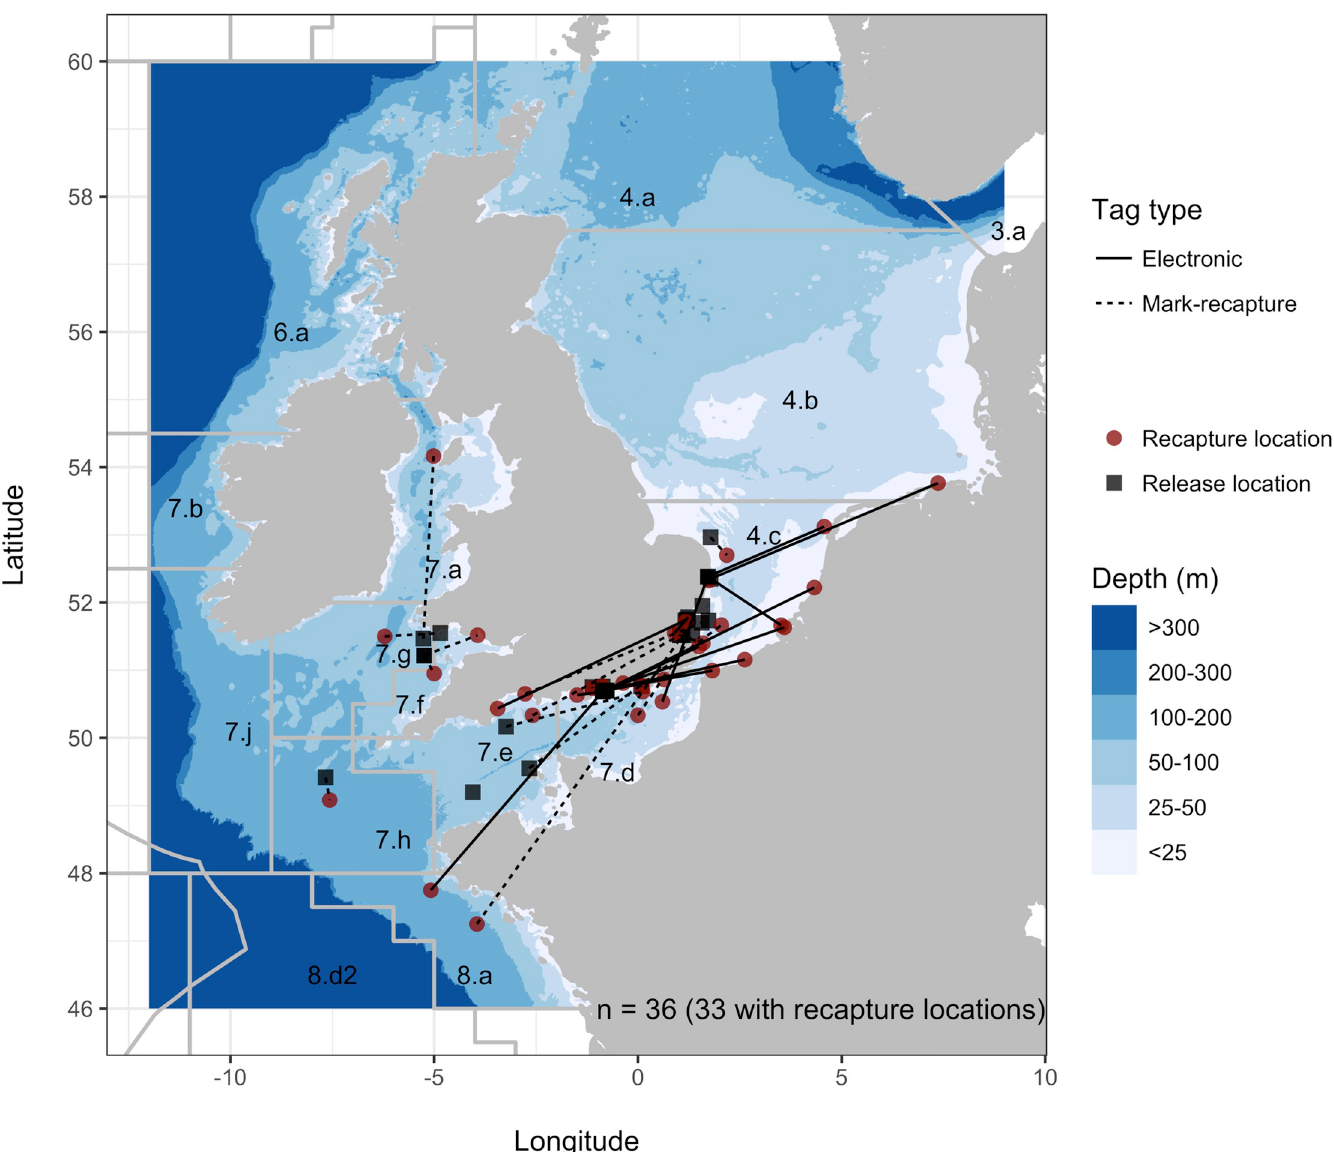
Fig 2. Release and recapture locations of tagged M . asterias . Release (black squares) and recapture (red circles) locations of M . asterias by tag type (mark-recapture, n = 18; electronic, n = 18; S4 and S5 Tables). Lines by tag type represent a straight-line between release and recapture locations and are designed to illustrate migration and